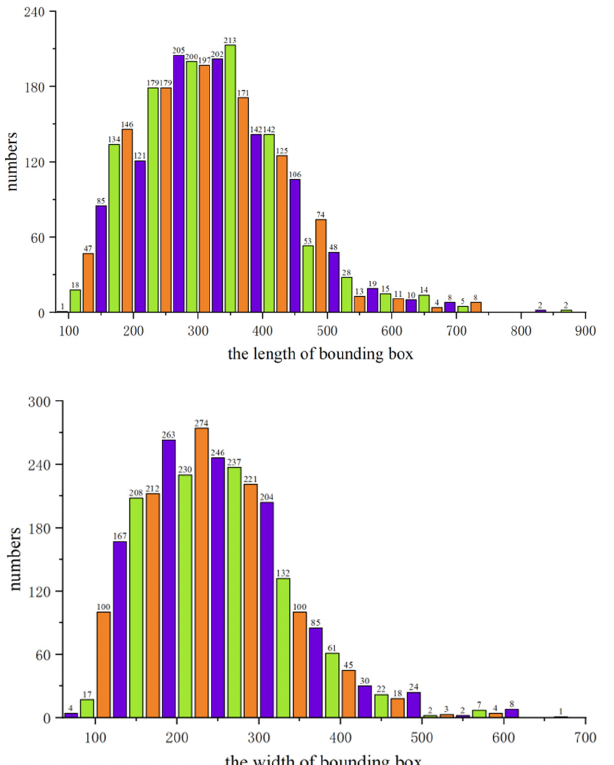
Figure 4. Statistical results of ship target bounding box length and width in the TISD dataset.